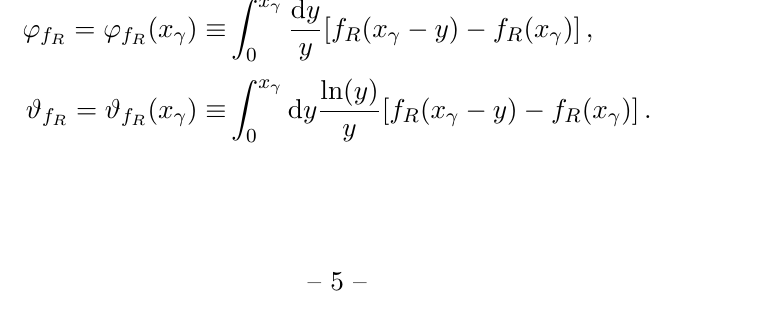
Figure 4 . Annihilation cross sections plotted as function of E (cid:13) cross section for the narrow resolution computed in [4]. The red-dashed line shows the intermediate resolution cross section. The light-grey (blue) area represents the region of validity for the narrow resolution case and the dark-grey (red) area represents the region of validity for the intermedi- ate resolution case. The ratio of the intermediate to narrow resolution annihilation cross section (cid:27)v = (cid:27)v is added below each plot. The results are shown for DM masses of m (cid:31) = 2 TeV h i int h i nrw (upper plot) and m (cid:31) = 10 TeV (lower